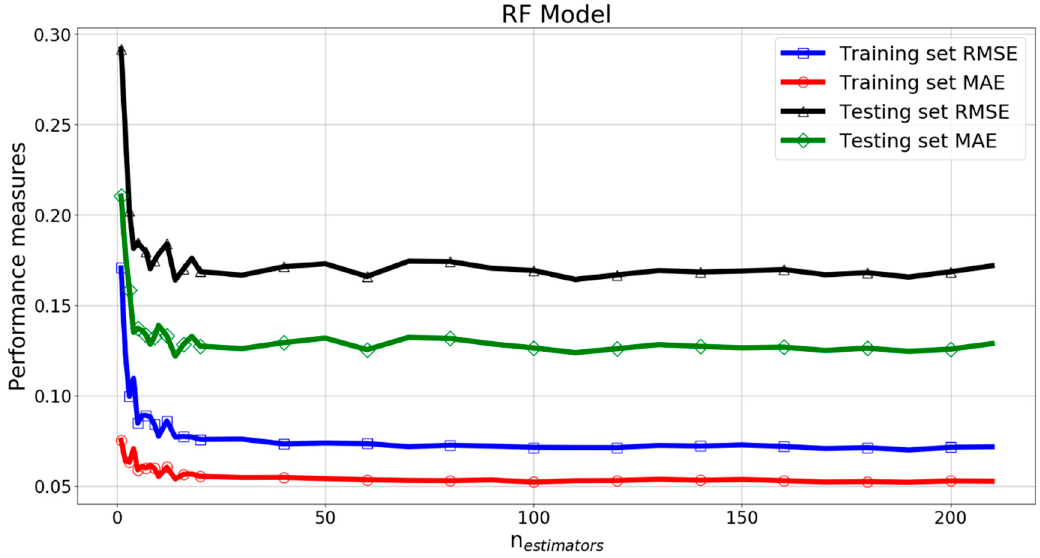
Figure 17. RMSE and MAE versus parameter n estimators for the RF model.